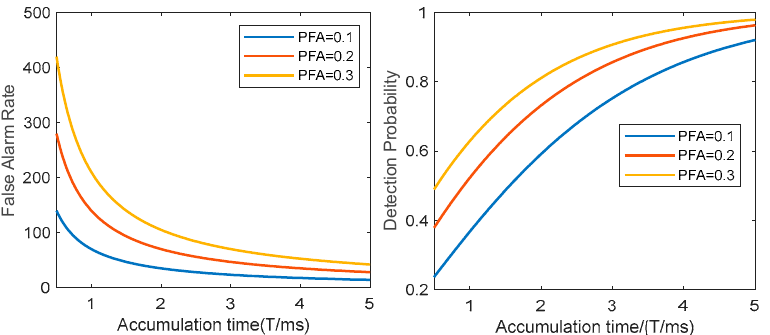
Figure 4. Variation in false alarm rate and detection probability with accumulation time with different detection probabilities for the given radar in the same scenario.